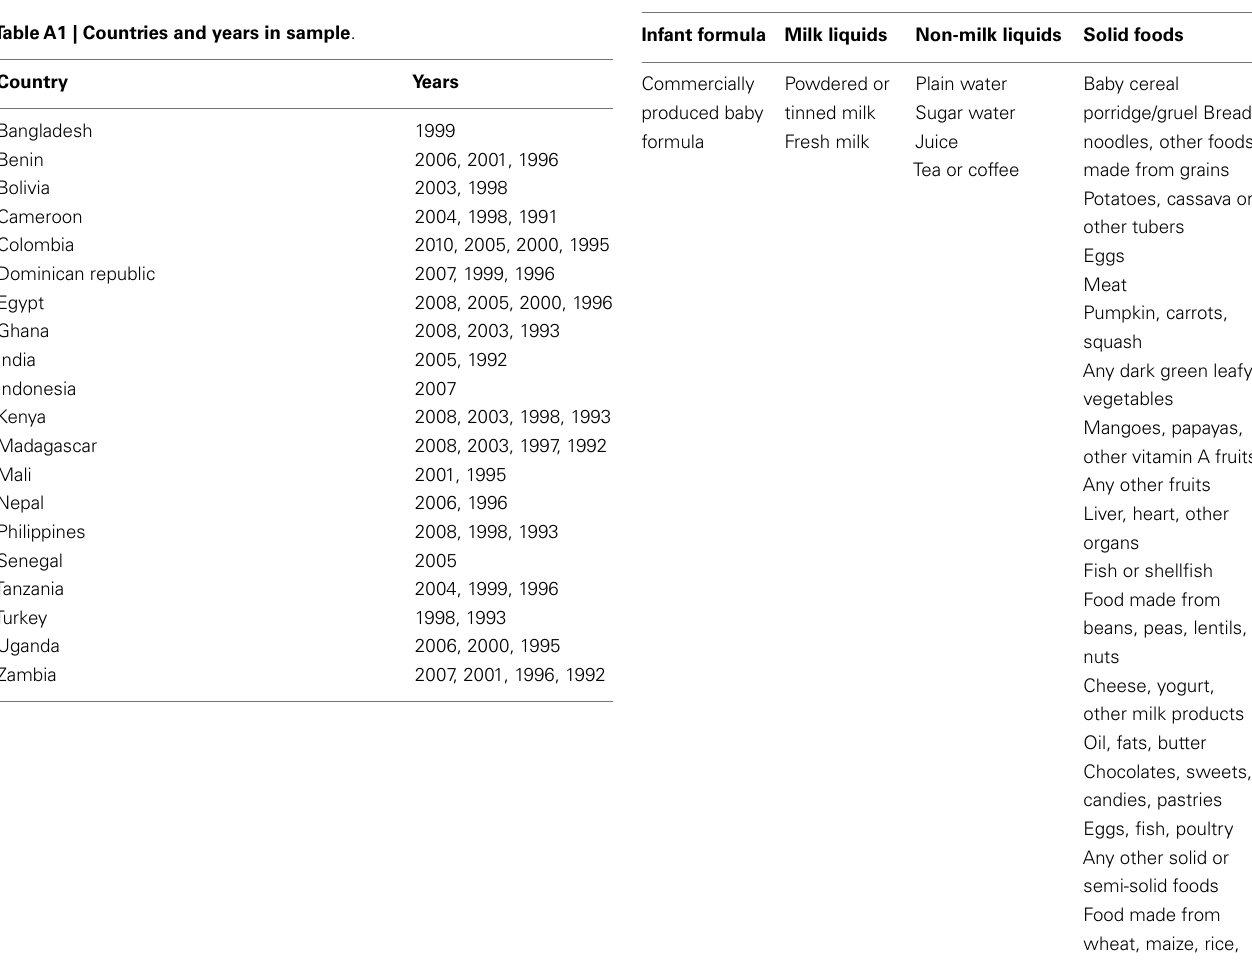
TableA2 | Food type definitions